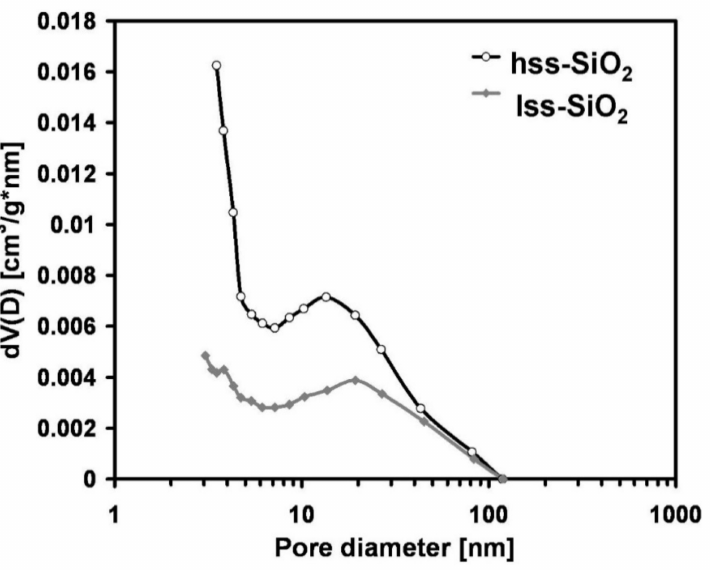
Figure 2. Pore size distribution of the silica powders determined from the desorption branch of nitrogen adsorption/desorption isotherms using BJH method (temperature 77